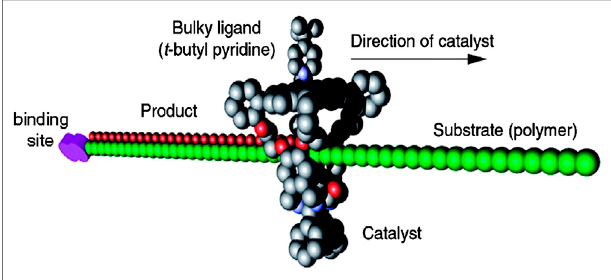
FIGURE 3 | The processive catalytic system containing a linear polymer and a macrocycle. The macrocycle is modi fi ed with catalytic center and restrained tothepolymer,whichactsasaxlemolecule intherotaxanesystem. As the macrocycle moves from one end to the other, the axle is functionalized (e.g., oxidation) sequentially by the catalyst. Reproduced from Deutman et al. (2014) with permission. Copyright 2014 American Chemical